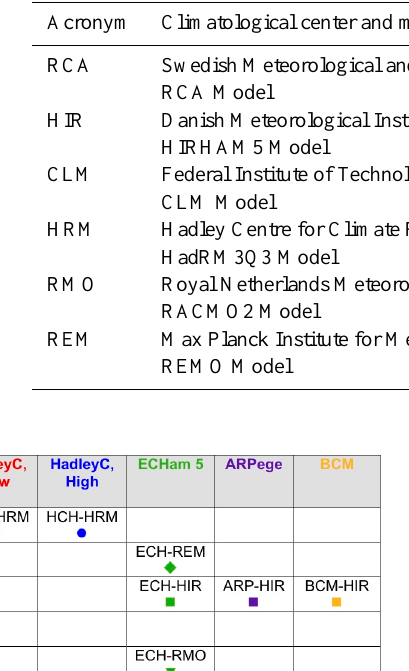
Table 3. Acronyms of the Regional Climate Models (RCMs) considered in this study.